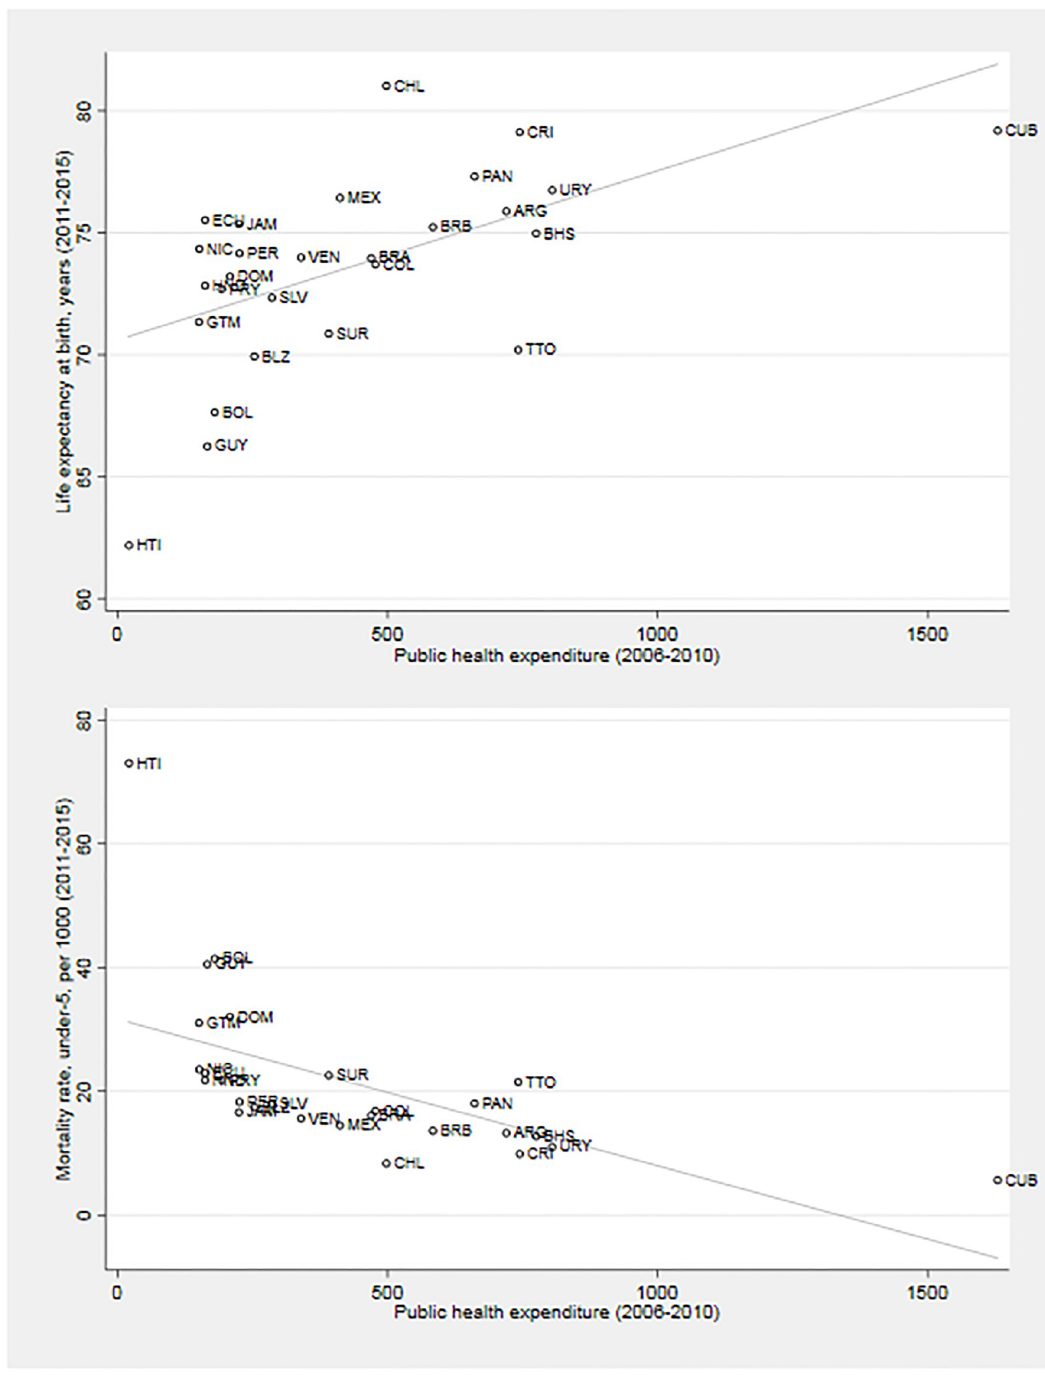
Fig 2. Life expectancy, under-five mortality and public health expenditure per capita in LAC.